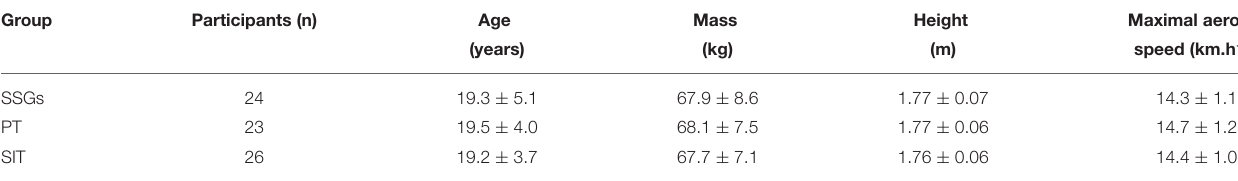
TABLE 1 | Characteristics of the participants.